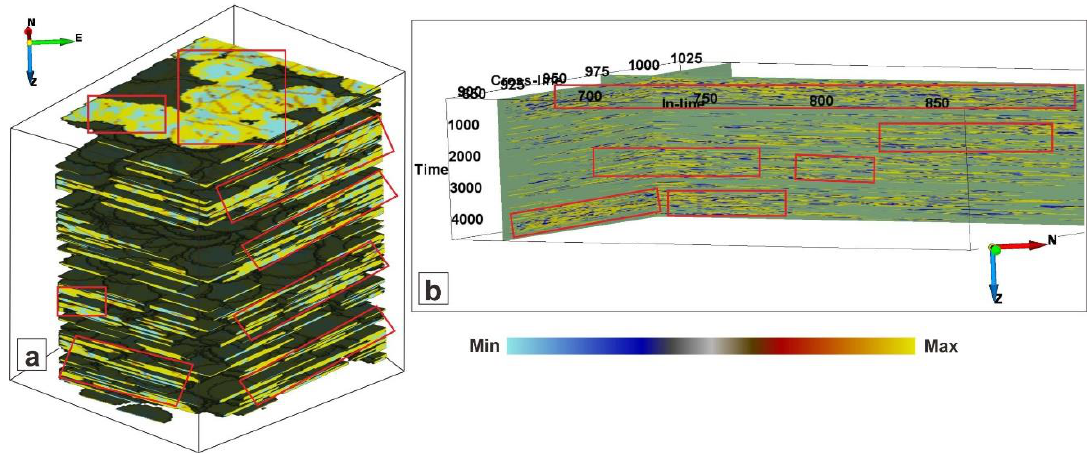
Figure 12. The results of the neural networks highlighting the fracture network: ( a ) ANN–UVQ cube and ( b ) ANN–UVQ section. Red rectangles show the fractured regions.